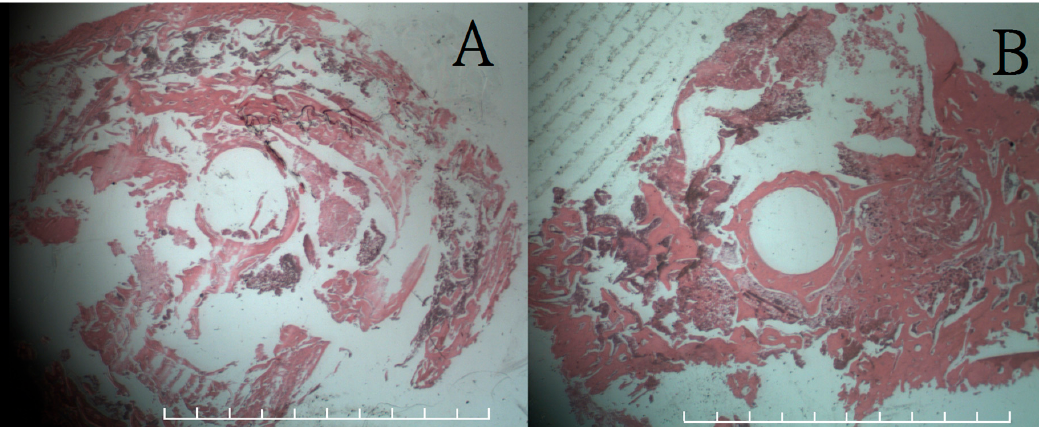
Figure 4. Histological results (200×) of coronal section on femoral bone defect site with hematoxylin and eosion (H & A) stain. ( A ) The results at 12 weeks showed no inflammatory overreaction around the inferior aspect of the defect site; ( B ) The results at 24 weeks revealed good bone callus formation around the entire defect site. Each frame rates one millimeter.